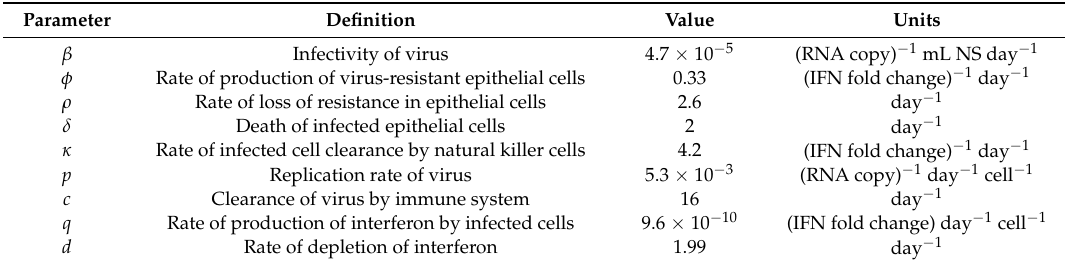
Table A1. Parameter definitions and values for the Pawelek model. (NS = nasal secretions, IFN = interfer).